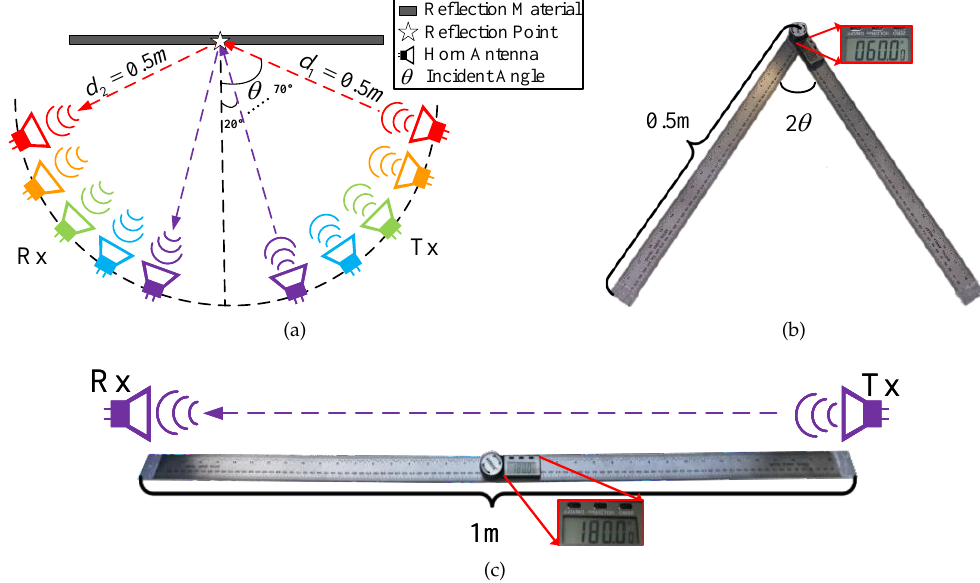
Figure 4. ( a ) Design of reflection measurements, ( b ) Angle ruler, ( c ) Design of LoS